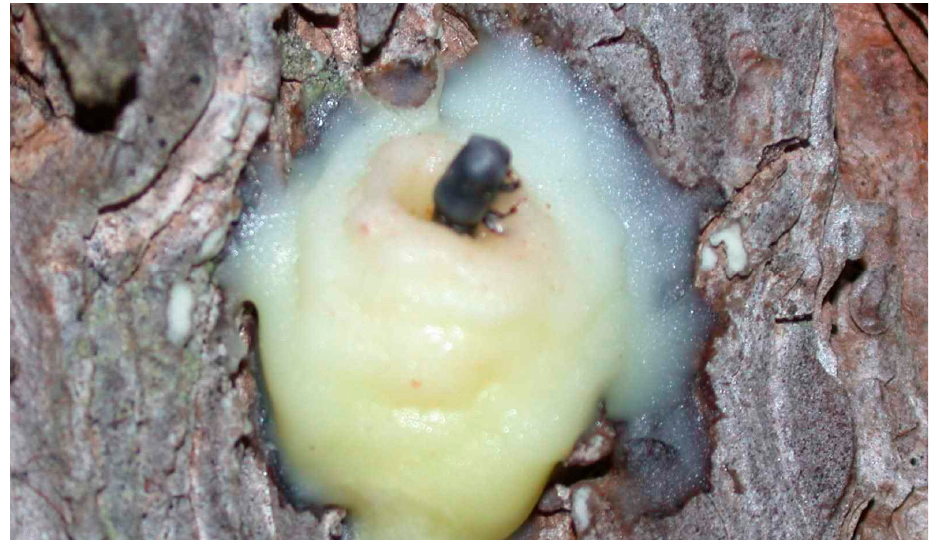
Figure 2. A western pine beetle ( Dendroctonus brevicomis ) killed in resin accumulated at the entrance hole, California. Photo credit: C.J. Fettig, USDA Forest Service.